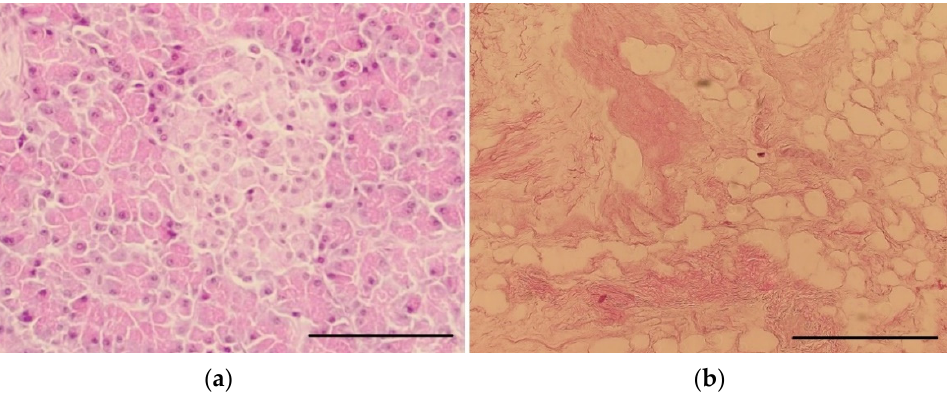
Figure 7. Elimination of nuclear material after decellularization and histological evaluation of de- cellularized pancreas—control tissue (( a ); 100 µm; magnification 6.3 kx) and decellularized tissue (( b ); 100 µm; magnification 6.3 kx).